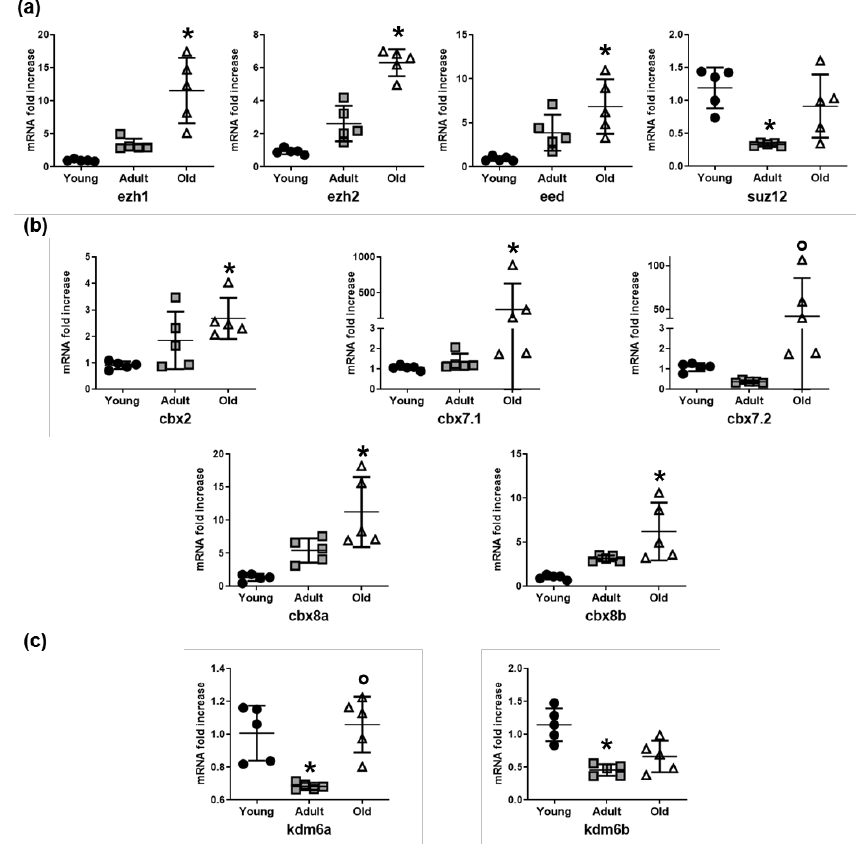
Figure 2. Histone methylation enzyme expression increases in Nfu muscle tissue with age. ( a ) qRT-PCR analysis of ezh1, ezh2, eed, and suz12, polycomb repressive complex 2 (PRC2) subunits in young (black circles), adult (gray squares), and old (white triangles) Nfu muscle tissue expressed as fold increase versus young samples ( n = 5). * p < 0.05 vs young. ( b ) qRT-PCR analysis of cbx2, cbx7.1, cbx7.2, cbx8a, cbx8b, a selection of polycomb repressive complex 1 (PCR1) mRNAs in young, adult, and old Nfu muscle tissue expressed as fold increase versus young samples. (n = 5). * p < 0.05 vs young; p < 0.05 vs adult. ( c ) qRT-PCR analysis of lysine demethylases kdm6a and kdm6b mRNAs in young, adult, and old Nfu muscle tissue expressed as fold increase versus young samples ( n = 5). * p < 0.05 vs young; p < 0.05 vs adult.